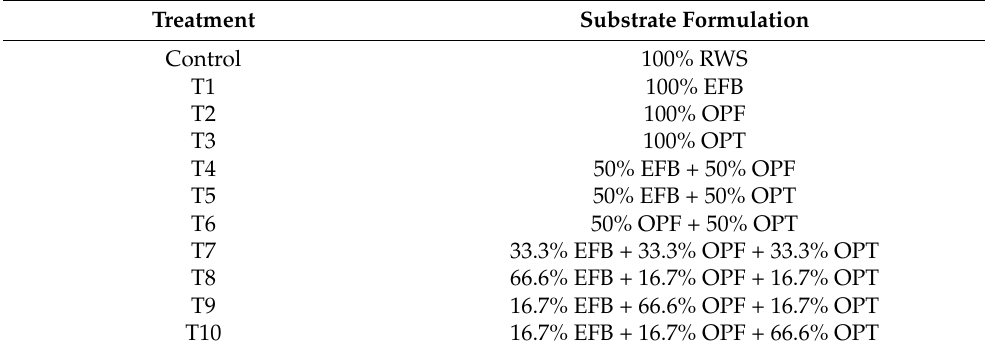
Table 1. Substrate formulation for each